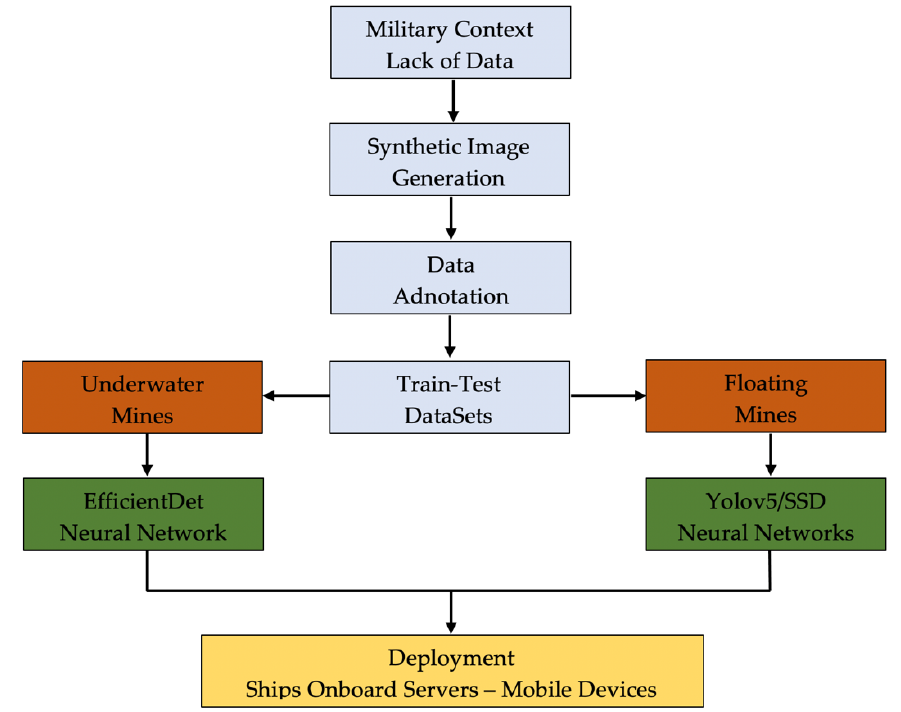
Figure 1. The framework structure of present research.